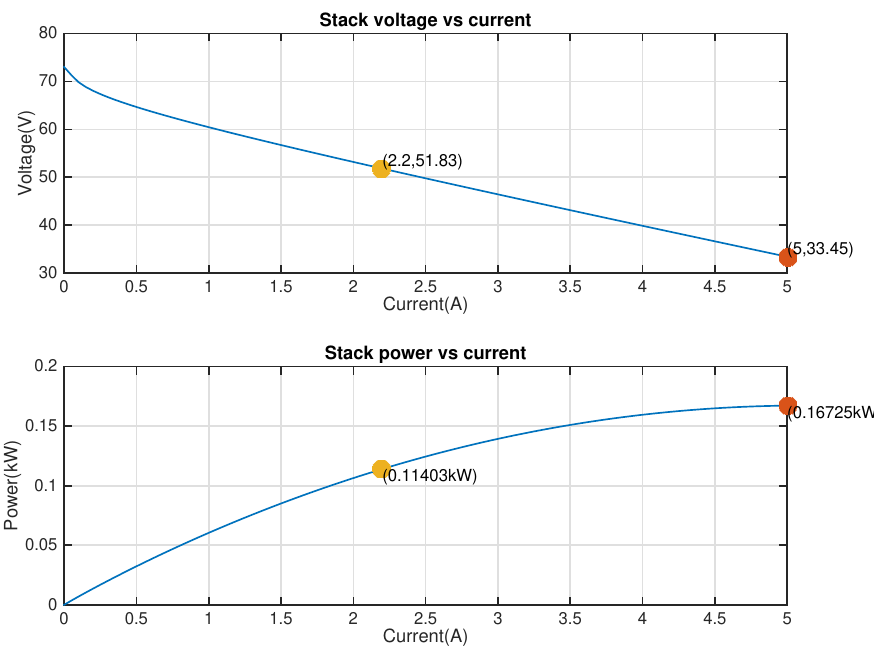
Figure 11. Polarization curve of the FC for passive configuration. The Simulink circuit made to simulate the passive hybrid power-train can be seen in Figure 12. It can be seen how the battery and fuel cell are directly coupled, with an inductor between them while the diode is included internally in the Simulink model of the FC.